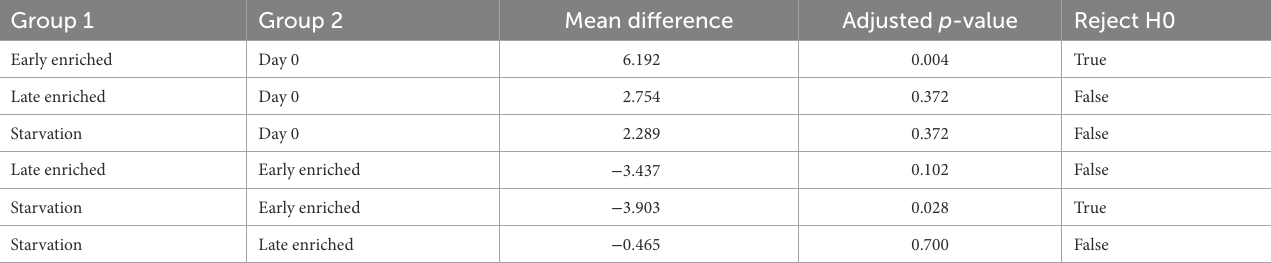
TABLE 2 Table showing the Tukey HSD test results based on wing δ 2 H between the four categories: (1) early enriched, (2) late enriched, (3) starvation, and (4) day 0. The table shows the compared categories (Group 1 − Group 2), the mean δ 2 H difference between the compared groups, the adjusted p -value and if the null hypothesis (H0) is